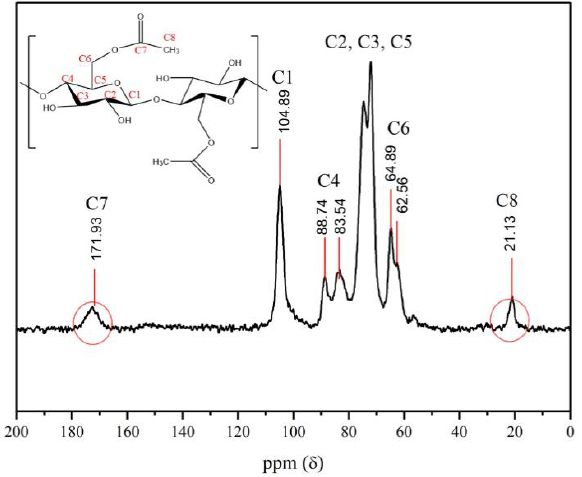
Figure 5. Cross-Polarization Magic Angle Spinning 13 C Nuclear Magnetic Resonance (CP-MAS/ 13 C NMR) spectrum for the CRS sample, indicating the different carbon types present in the CRS structure.